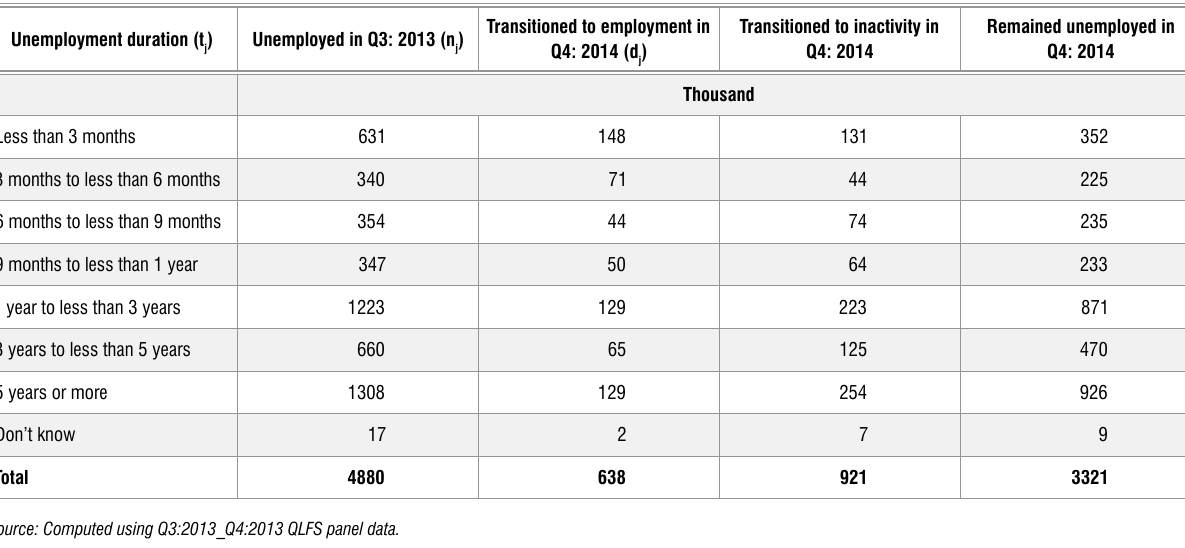
Labour market transitions for each unemployment duration considered